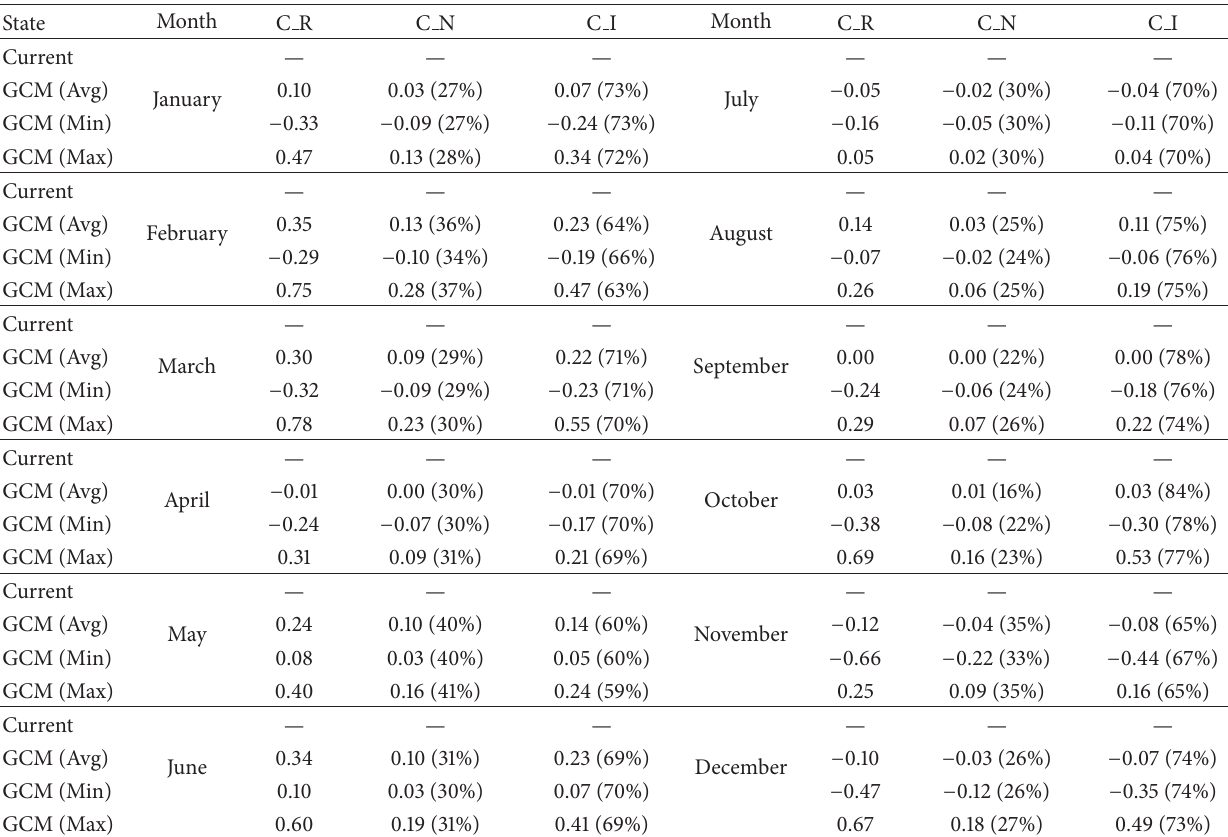
Table 5: Division of the change of monthly rainfall amounts (C R) into the change of the mean number of wet days (C N) and the change of the mean daily rainfall intensity (C